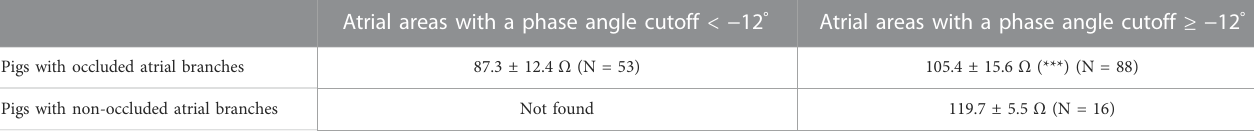
TABLE 2 Magnitude of the atrial myocardial impedance at 1 kHz in pigs with and without atrial coronary artery branch occlusion. Atrial areas with a phase angle cutoff < − 12 ° Atrial areas with a phase angle cutoff ≥ − 12 ° Pigs with occluded atrial